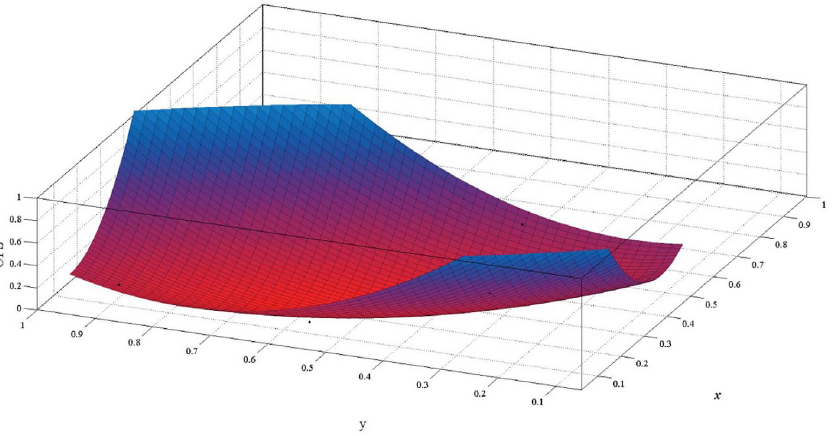
Fig 7. Polynomial regression model of x , y and OPS